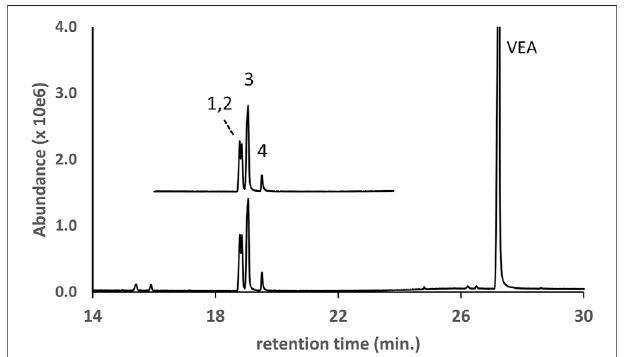
FIGURE 6 | GC-MS chromatogram for a vaping liquid ( lower trace ) in which multiple DPG dibenzoate isomers (peak labels 1 – 4) were identi fi ed in addition to VEA (VEA peak offscale). The DPG dibenzoate standard chromatogram ( upper trace , offset) shows a similar distribution of the four isomers. The vaping liquid contained only a trace of d9THC (peak not visible on current scale).